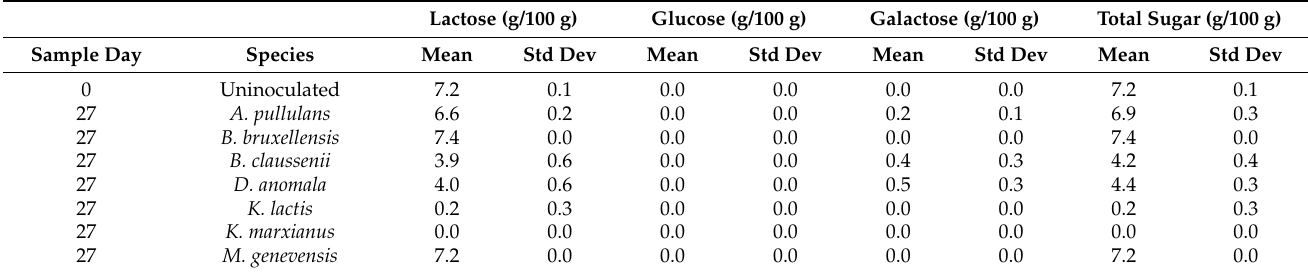
Table 1. Sugar concentrations under anaerobic fermentation (g/100 g).